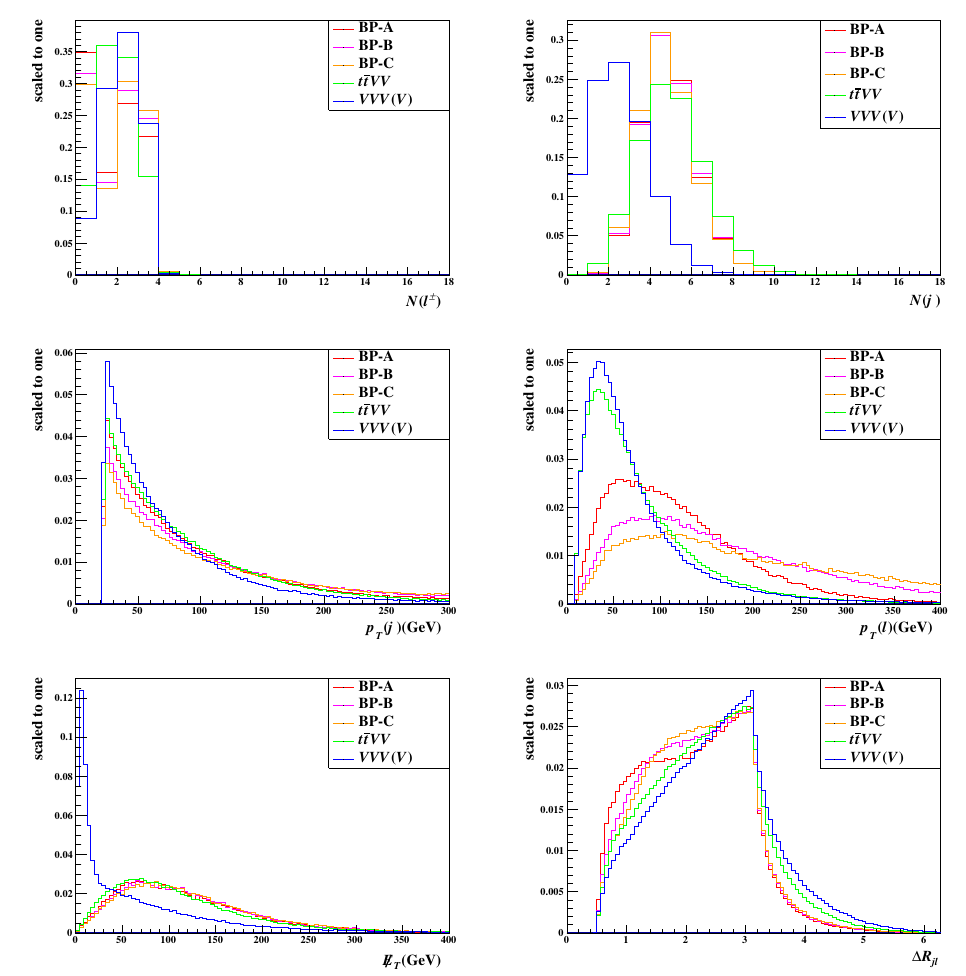
Figure 13 . Distributions of numbers of same-sign leptons N ( ‘ (cid:6) ) and jets N ( j ), transverse momenta p T ( j ) and p T ( ‘ ), missing transverse energy =E , and relative distances (cid:1) R j‘ for the SST signature T and corresponding backgrounds at 13 TeV